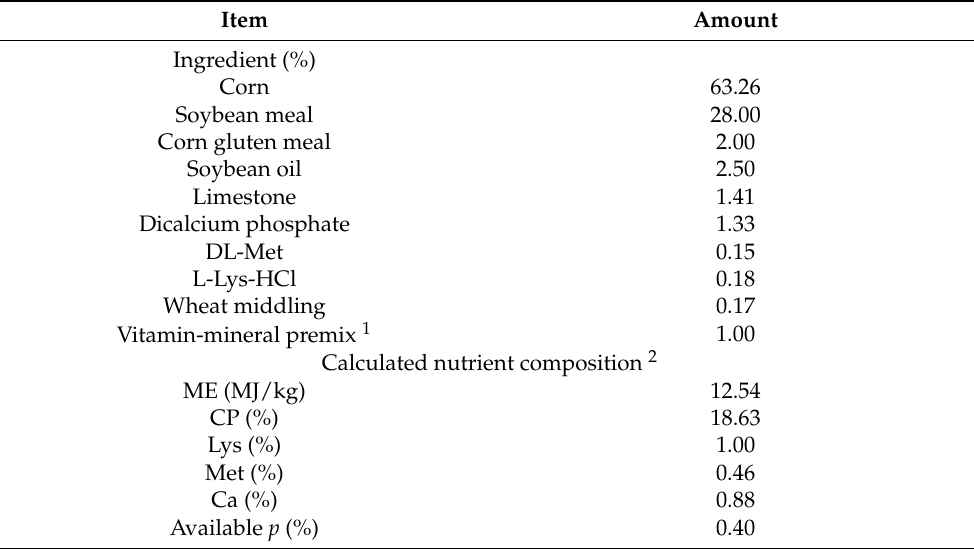
Table 1. The ingredient and nutrient level of the basal